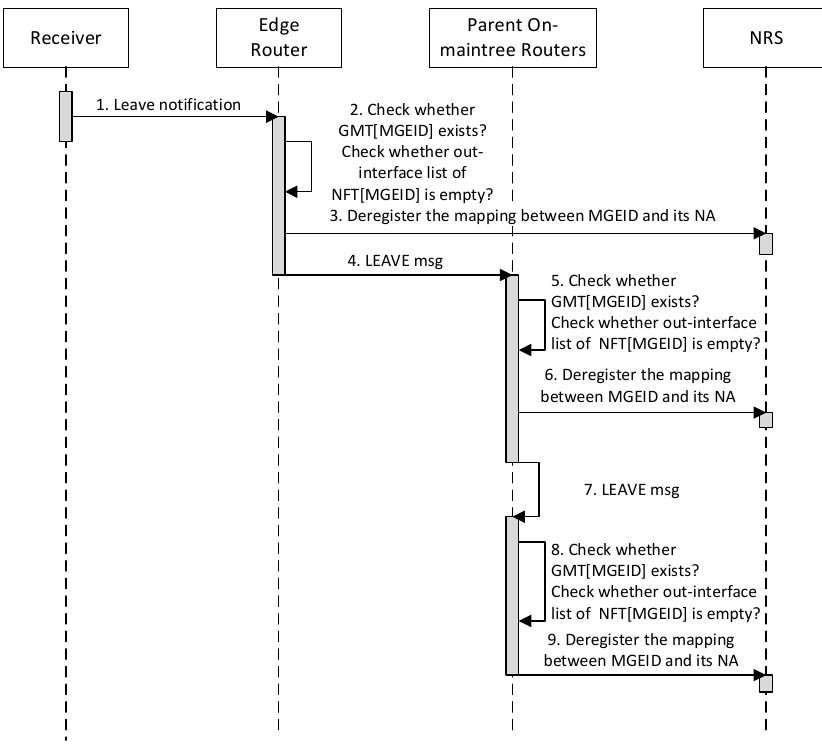
Figure 5. The message sequence chart diagram of joining a group.